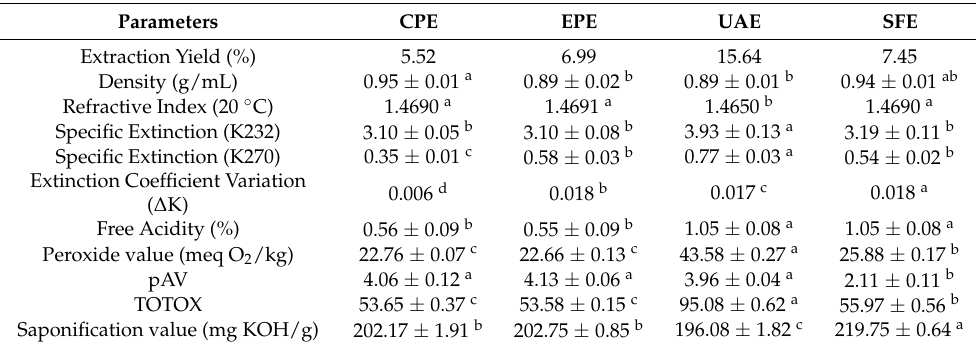
Table 1. Extraction yields and quality parameters of the sinami oils that were obtained using the four extraction